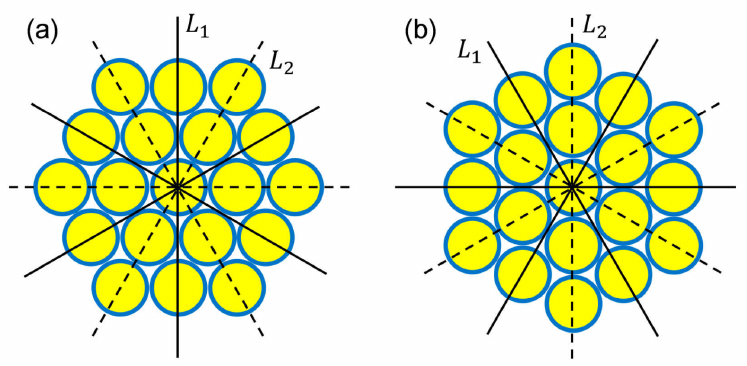
Figure 7. Two FOP arrangements. ( a ) FOP was rotated counterclockwise by 0, π /3, 2 π /3 or π . ( b ) FOP was rotated counterclockwise by π /6, π /2 or 5 π